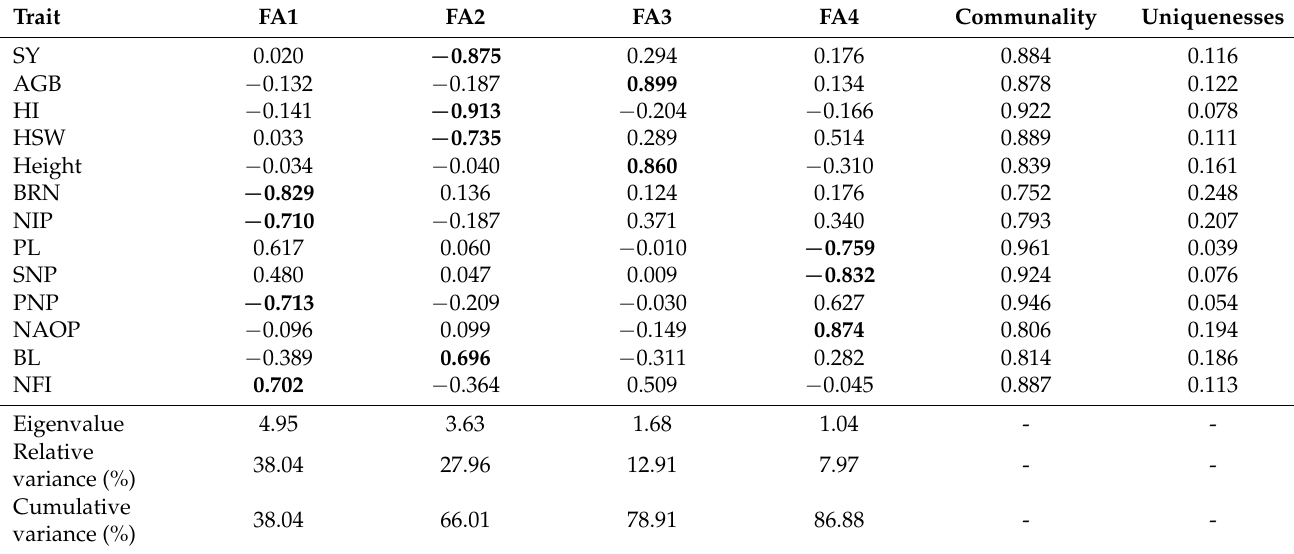
Table 3. Factorial analysis of 13 faba bean traits.